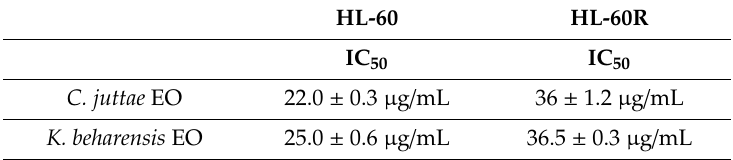
Figure 3. Relative (%) amounts of each chemical class and the functional group identified in Cyphostemma juttae and K. beharensis. Table 2. IC 50 values of the two cell lines treated with the essential oils of C. juttae and K.